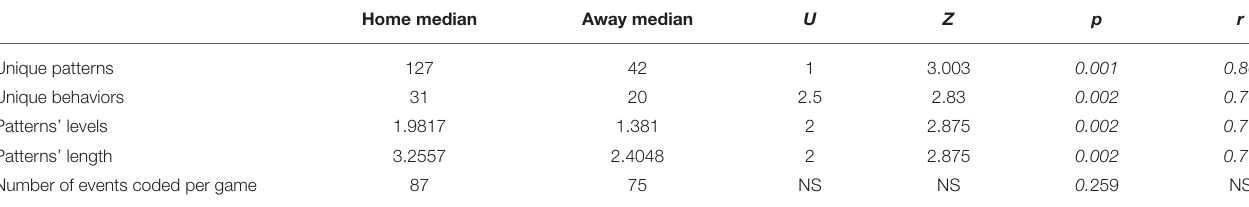
TABLE 2 | Results